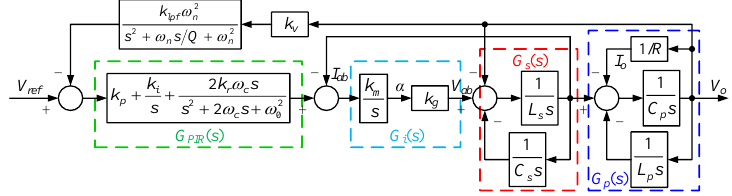
Figure 11. The whole control block diagram of LCLC resonant inverter.